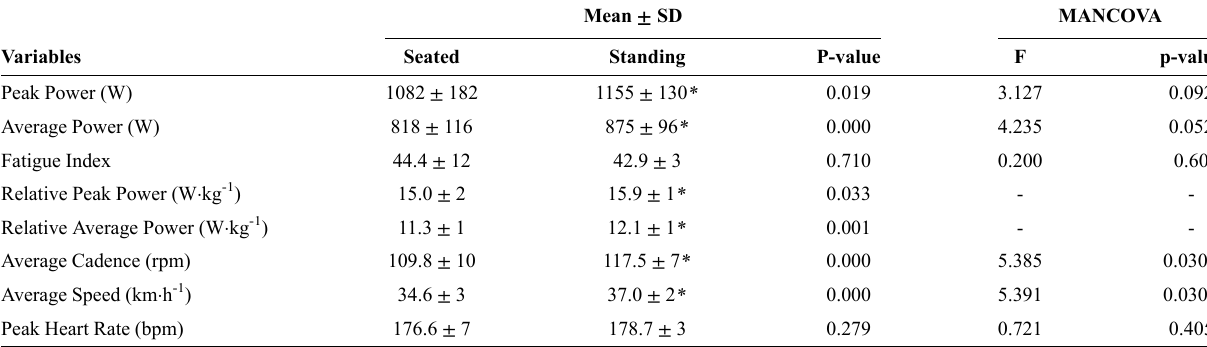
Table 2 - Variables obtained in the Wingate Test in both positions.